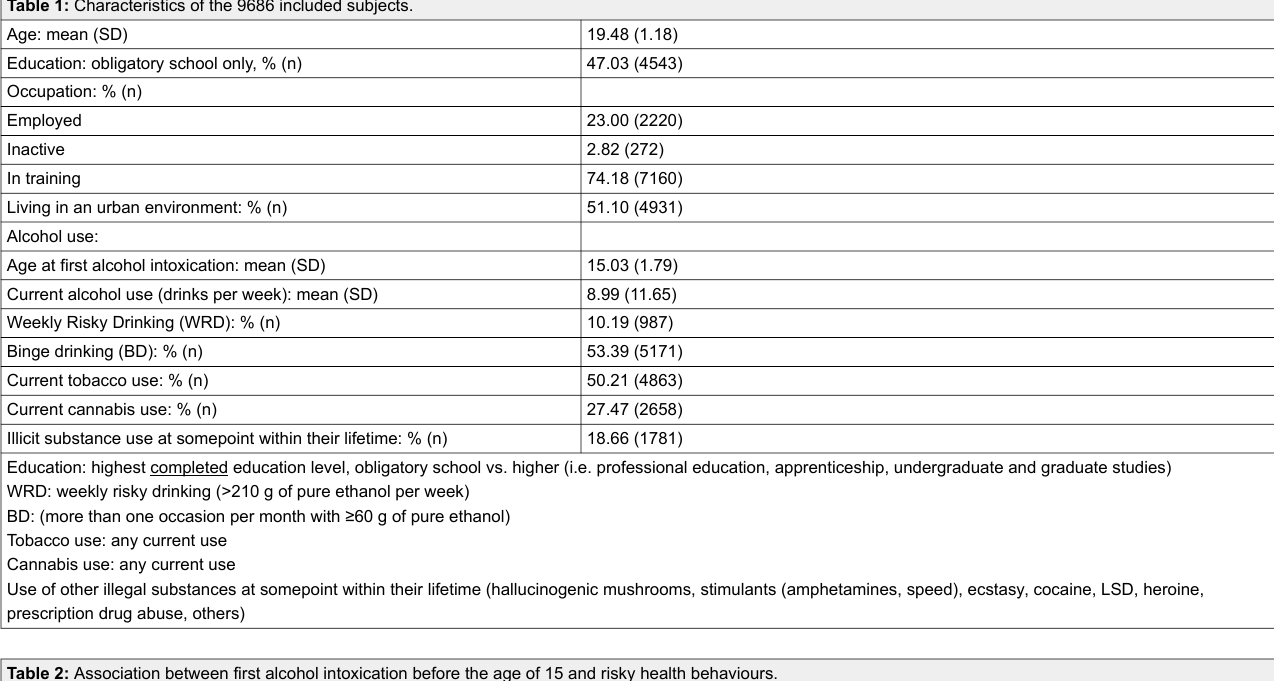
Table 2: Association between first alcohol intoxication before the age of 15 and risky health